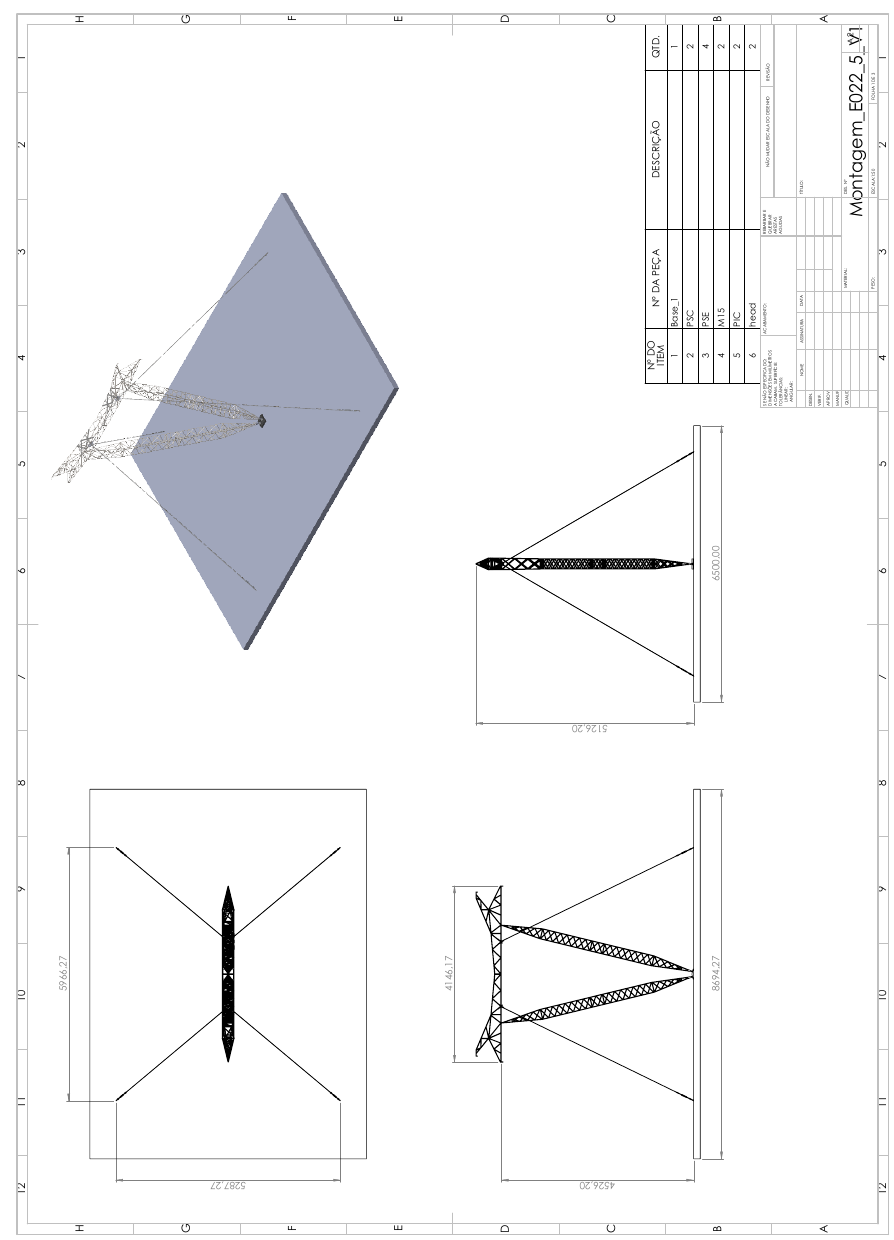
Figure 14. Drawing of the mockup guyed